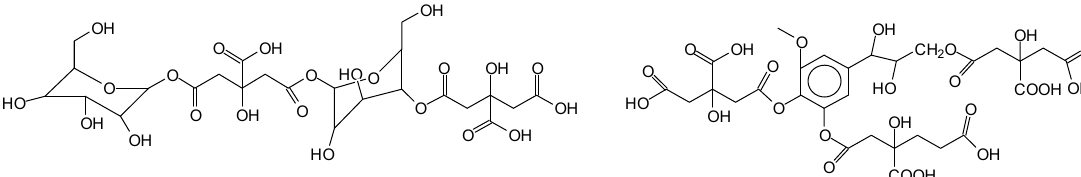
Figure 4. Example of citric acid bridges linking glucoses or holocellulose chains, and actually identified reaction products of citric acid with lignin. The compounds shown have been identified among several others of the same type, showing that both holocellulose and lignin are involved in wood bonding and citric acid bridge-forming by citric acid alone [116].